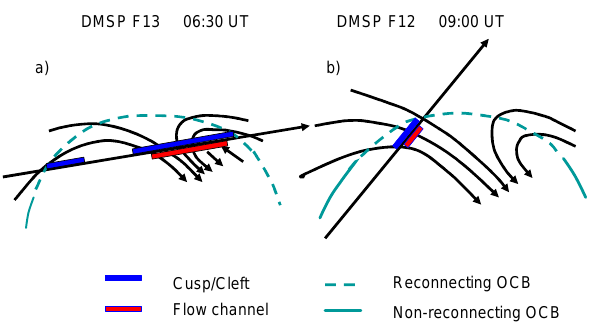
Fig. 7. Diagrams summarizing the information derived from the Figure 7 two satellite passes. Notably, the flow-reversal boundary observed on the prenoon sector of the F13 pass was located ∼ 300km pole- ward of the open-closed field-line boundary, which is evidence of sunward return flow along open field